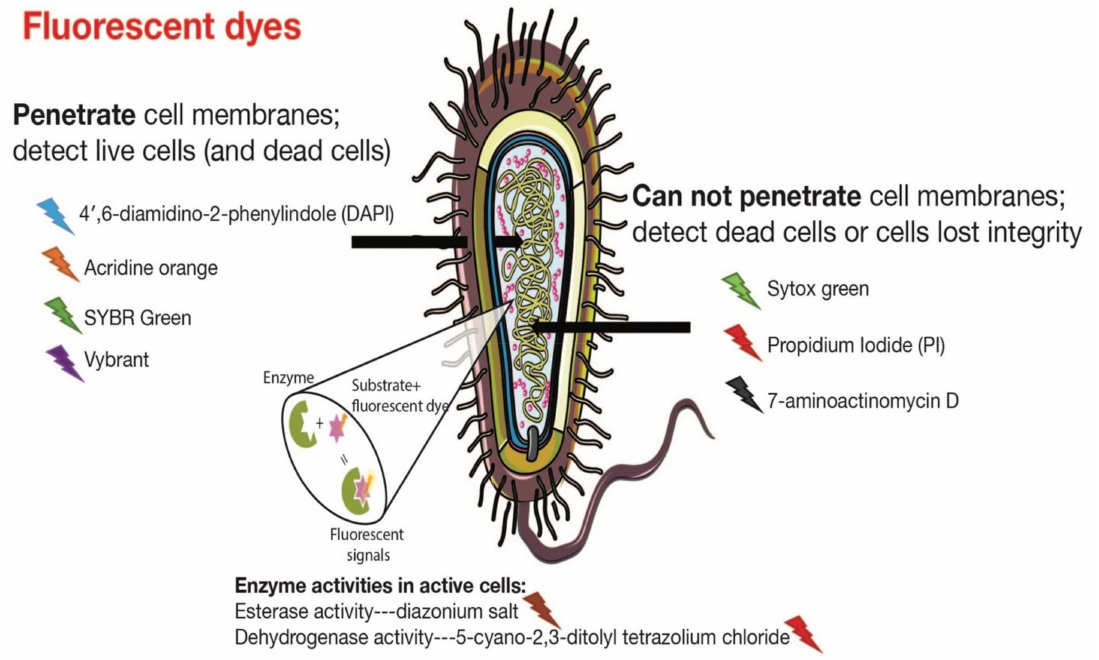
Figure 1. Stains 4 (cid:48) ,6-diamidino-2-phenylindole (DAPI; blue color), acridine orange (orange color), SYBR Green I (green color), and Vybrant (red) can penetrate cells and stain the double-stranded DNA. Sytox Green (green color), 7-aminoactinomycin D, and propidium iodide (PI; red color) are cell impermeable and can only stain dead cells or cells that have lost membrane integrity. Active bacteria quantification can be accomplished using certain dyes targeting metabolic functions, such as esterase (diazonium salt) and dehydrogenase activity (5-cyano-2,3-ditolyl tetrazolium